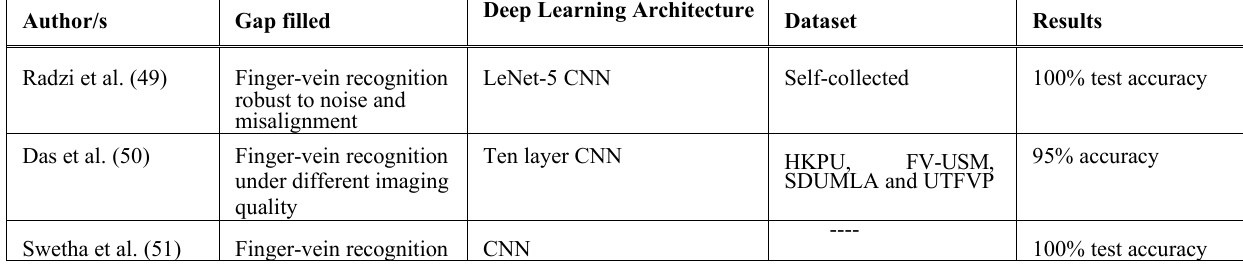
Table 5. Important works on Finger-vein based identification using deep learning.